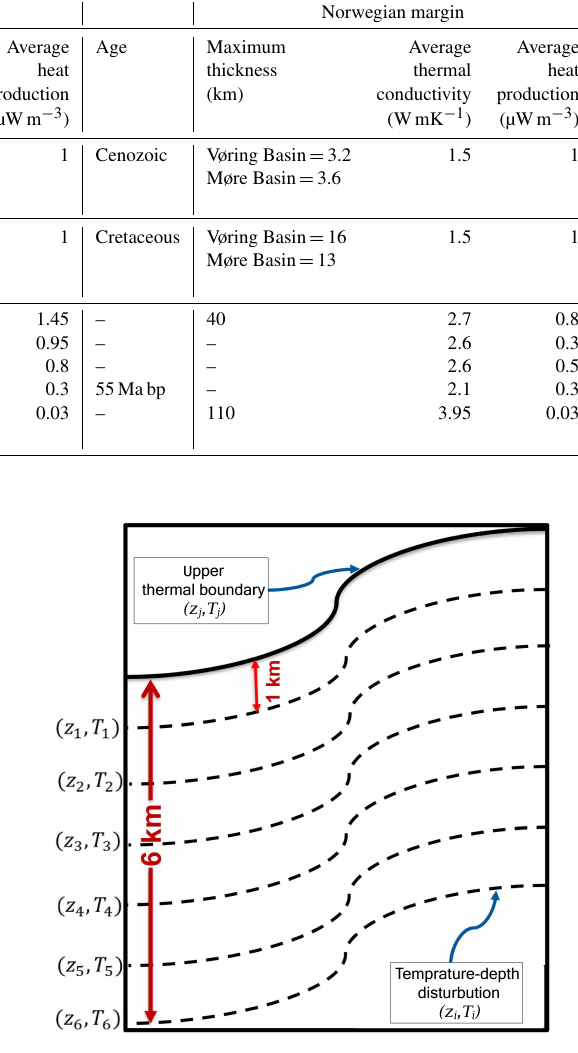
Figure 1. The geothermal gradient calculation: schematic of the temperature–depth distributions in 1km homogeneous depth in- tervals down to 6km below the upper thermal boundary sur- face to calculate the geothermal gradient between the uppermost surface ( z j ,T j ) and the corresponding depth levels ( z i ,T i ). The temperature–depth distribution maps are presented as Figs. S1 and S2.